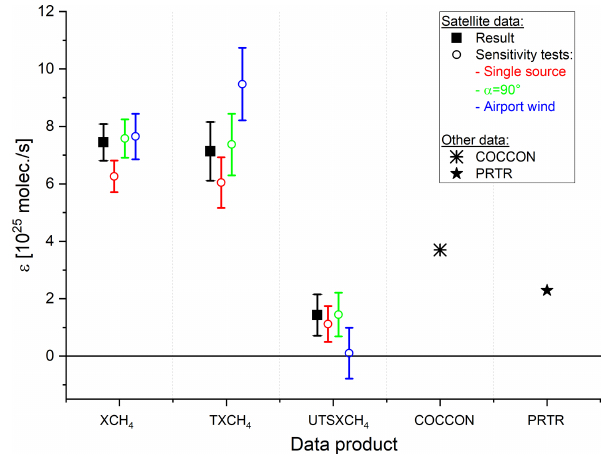
Figure 10. Emission strengths for the different products and for the sensitivity tests. Also included are the COCCON observations which characterize the Valdemingómez waste plant contribution and the total of all three sources according to the PRTR